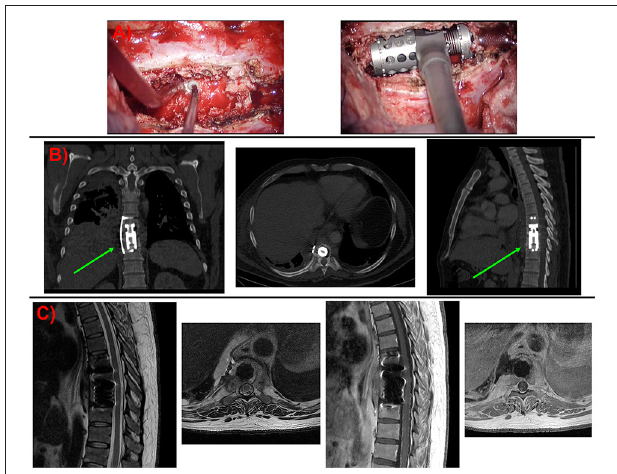
FIGURE 2 | (A) Intraoperative images. Pathological bone in the affected vertebrae was drilled with a high-speed drill. Once the vertebrectomy was done, an expandable cage was fitted inside. (B) Coronal, axial, and sagittal CT views after surgery. No complications related to the approach or osteosynthesis materials were identified. (C) MRI images were taken after surgery. Note the evacuation of the epidural mass and the decompression done on the spinal cord in the axial views. Green arrow, osteosynthesis material (expandable titanium cage with a lateral fixation plate).